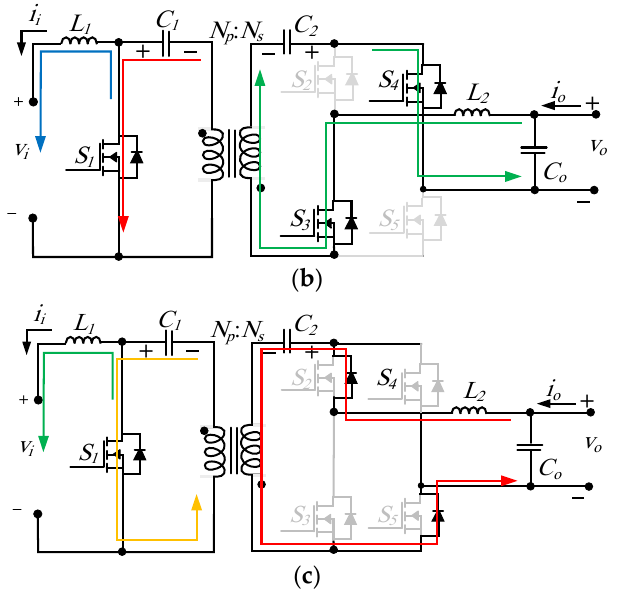
Figure 9. Cuk MI as an AC/DC rectifier when i o is positive: ( a ) St rec 1 , ( b ) St rec 2 , and ( c ) St rec 3 .